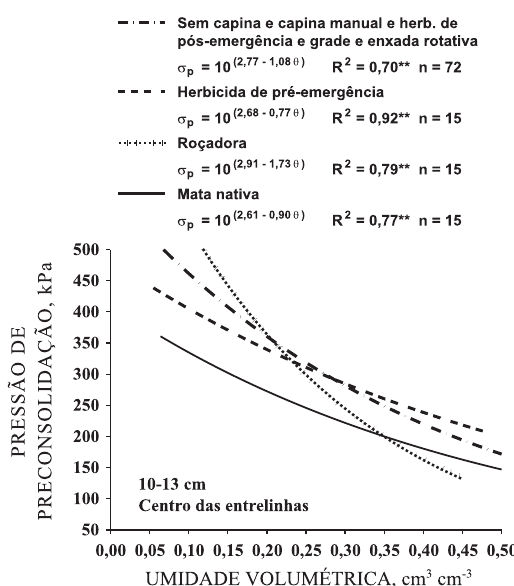
Figura 5. Modelos de capacidade de suporte de carga para um Latossolo Vermelho distroférrico sob mata nativa e cultivado com cafeeiros, submetido a diferentes sistemas de manejo de plantas invasoras na posição de amostragem centro das entrelinhas dos cafeeiros, na profundidade de 10–13